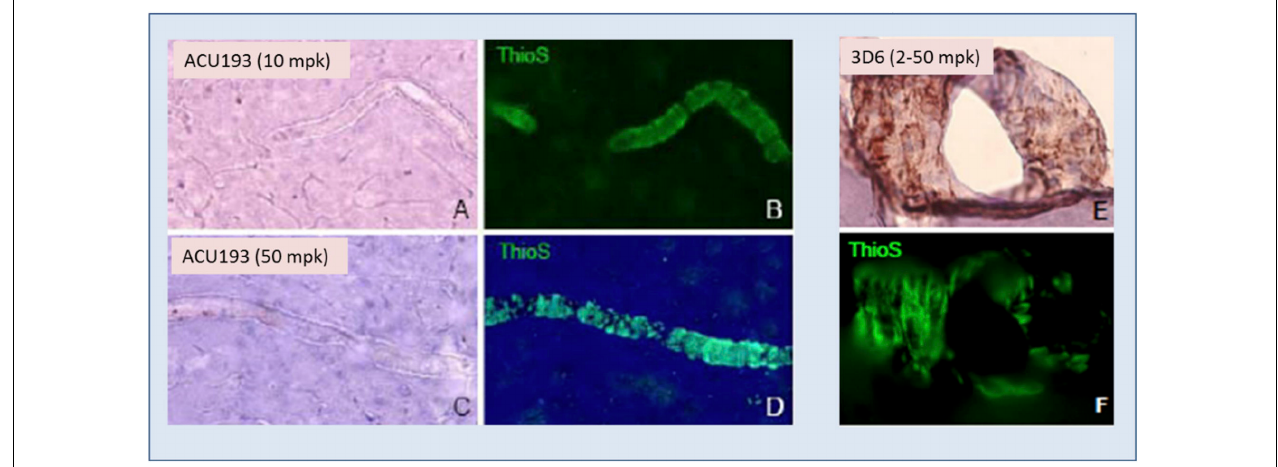
FIGURE 5 | ACU193 (A,C) shows no binding to the vascular amyloid that is visible in the vessels stained by thioflavin-S (ThioS, green fluorescence, B,D ) in the brain 24 h following IV dosing of 10 or 50 mg/kg (mpk) in 7- to 8-month-old Tg2576 mice. In contrast, hu3D6 (bapineuzumab) binds vascular amyloid (E,F) at all dose levels assessed (Krafft et al., 2012).